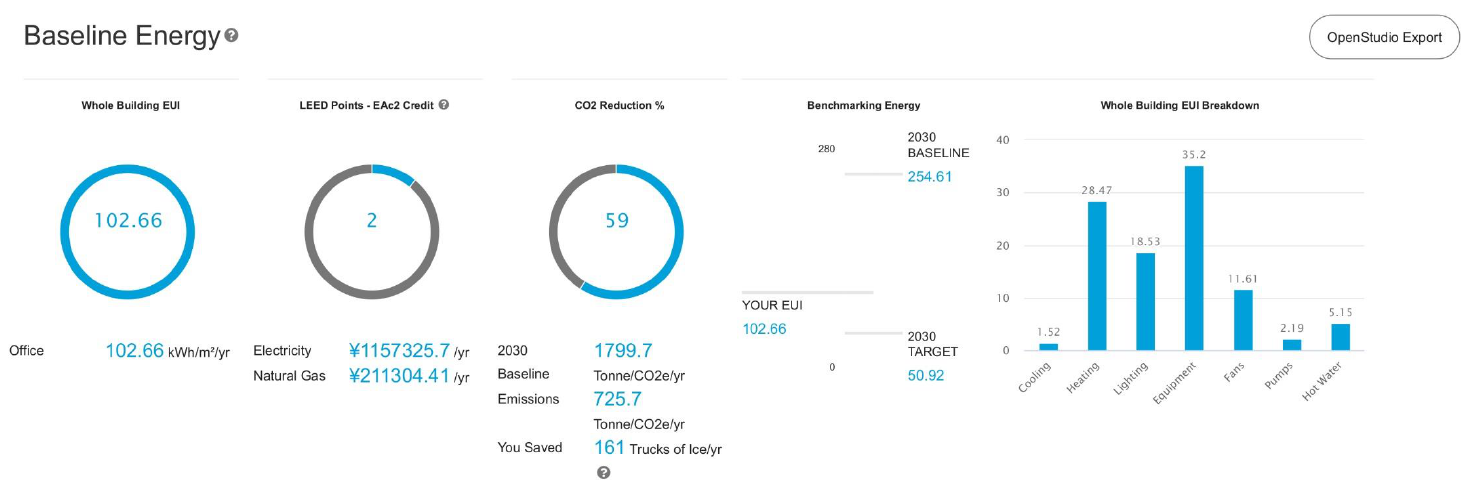
Figure A10. Zone 3-C Kunming, Yunnan (pre-COVID-19 scenario).